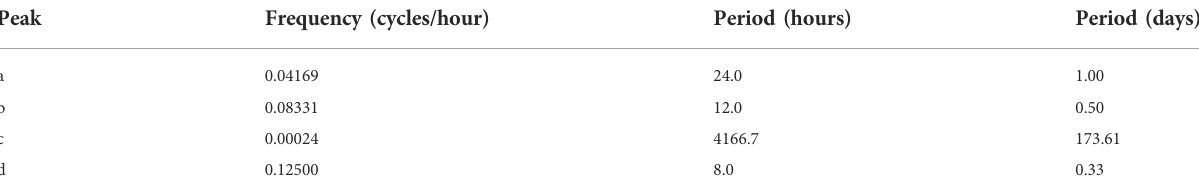
TABLE 3 Frequency and period characteristics of peaks on the ROTI periodogram. Peak Frequency (cycles/hour) Period (hours) Period (days) a